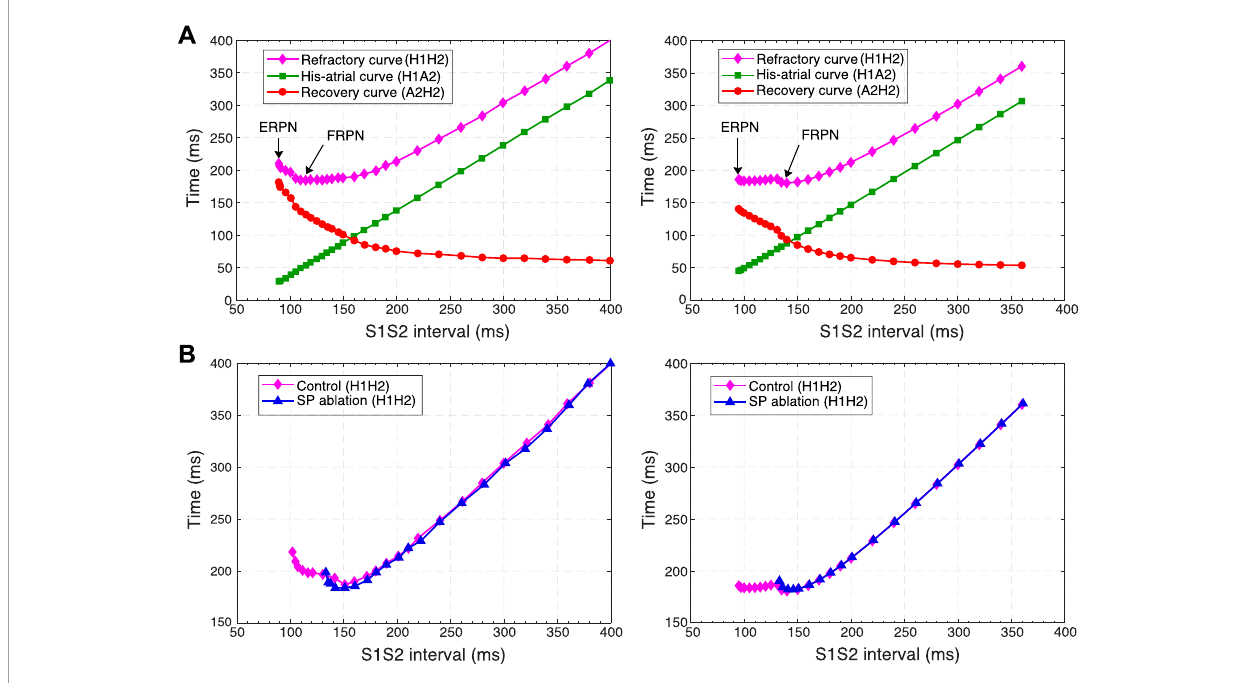
FIGURE 10 Comparison of experimental (left panels) and simulated (right panels) conduction curves. (A) Experimental (Tadros and Billette, 2012) and simulated AVN refractory, His-atrial, and recovery curves. (B) Experimental (Xu et al., 2006) and simulated refractory curves before and after SP ablation. The simulated control refractory curves (H1H2) in the right panels are the same.